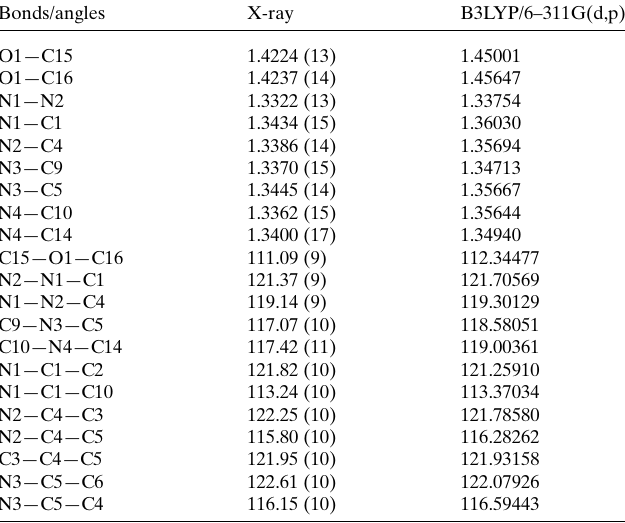
Table 3 Comparison of the selected (X-ray and DFT) geometric data (A˚ , (cid:2) ). Bonds/angles